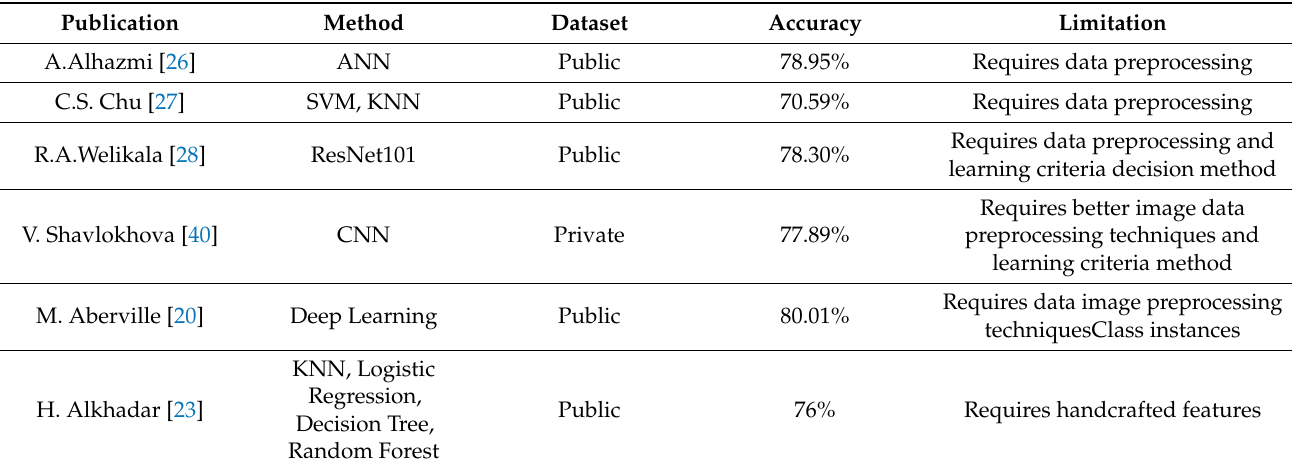
Table 1. Compare and weaknesses of previous